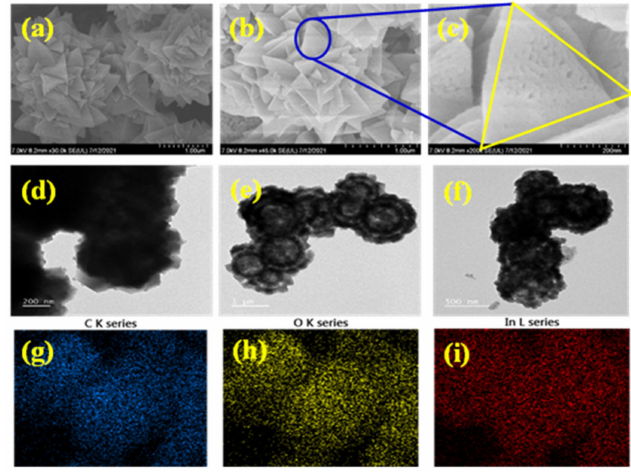
Figure 4. SEM images for In 2 O 3 -MF ( a – c ); TEM images for In 2 O 3 -MF ( d – f ); elemental mapping images for In 2 O 3 -MF ( g – i